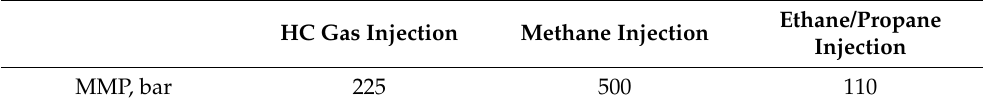
Table 5. MMP values for different injected compositions.